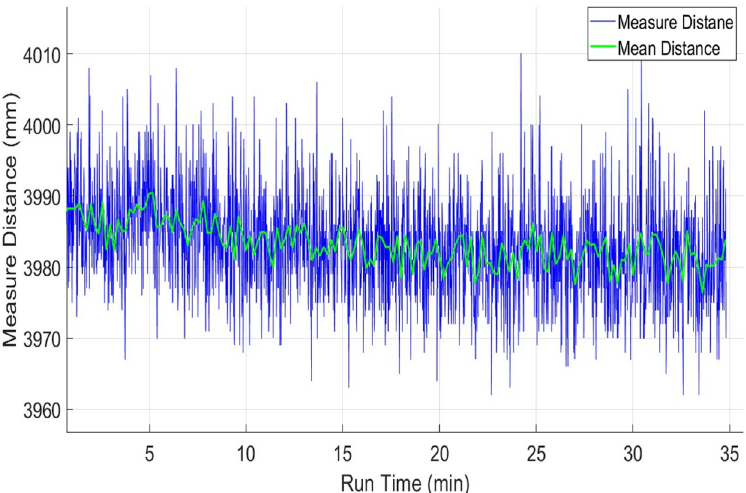
Fig 9. Drift test of URG-04LX using range measurements of four meter